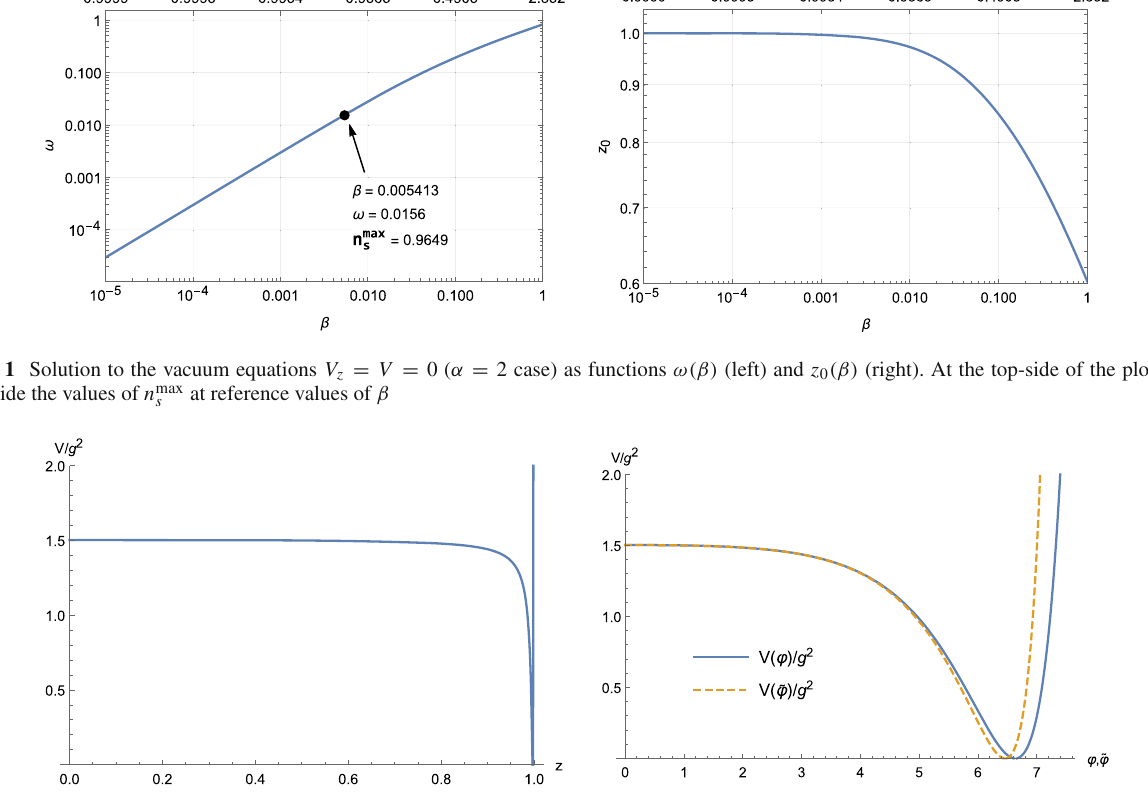
Fig. 2 Left: The scalar potential (7) + (8). Right: The same potential when using the canonical parametrization z (ϕ) found by numerically inverting the function (13) – shown as the solid curve. The dashed curve